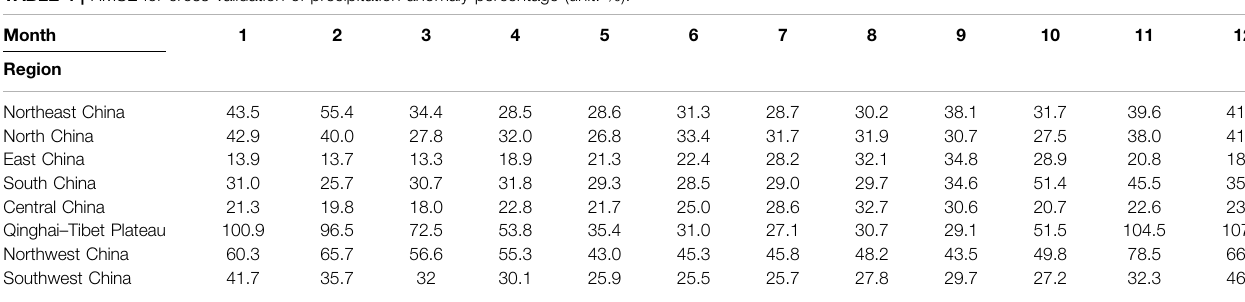
TABLE 4 | RMSE for cross-validation of precipitation anomaly percentage (unit: